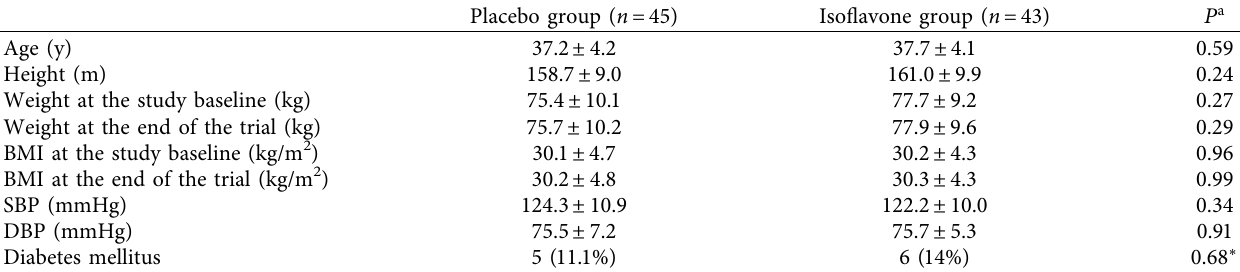
Table 1: General characteristics of study participants.